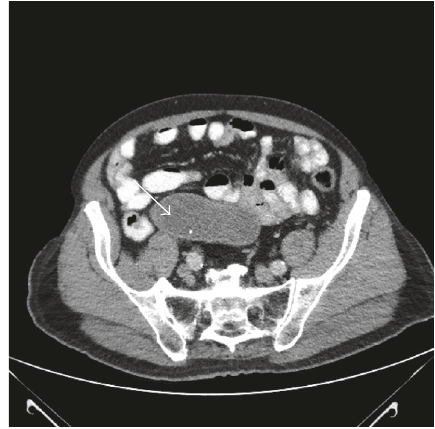
Figure 2: Follow-up CT abdomen pelvis showing a dilated tubular structure arising from the medial aspect of the caecum with unchanged features suggestive of a benign appendicular mucocele and no other intra-abdominal pathology.